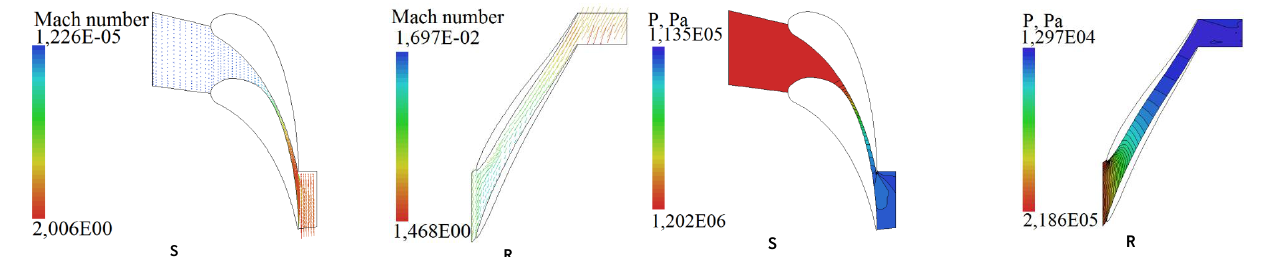
in a meridional section at the mid blade-to-blade section